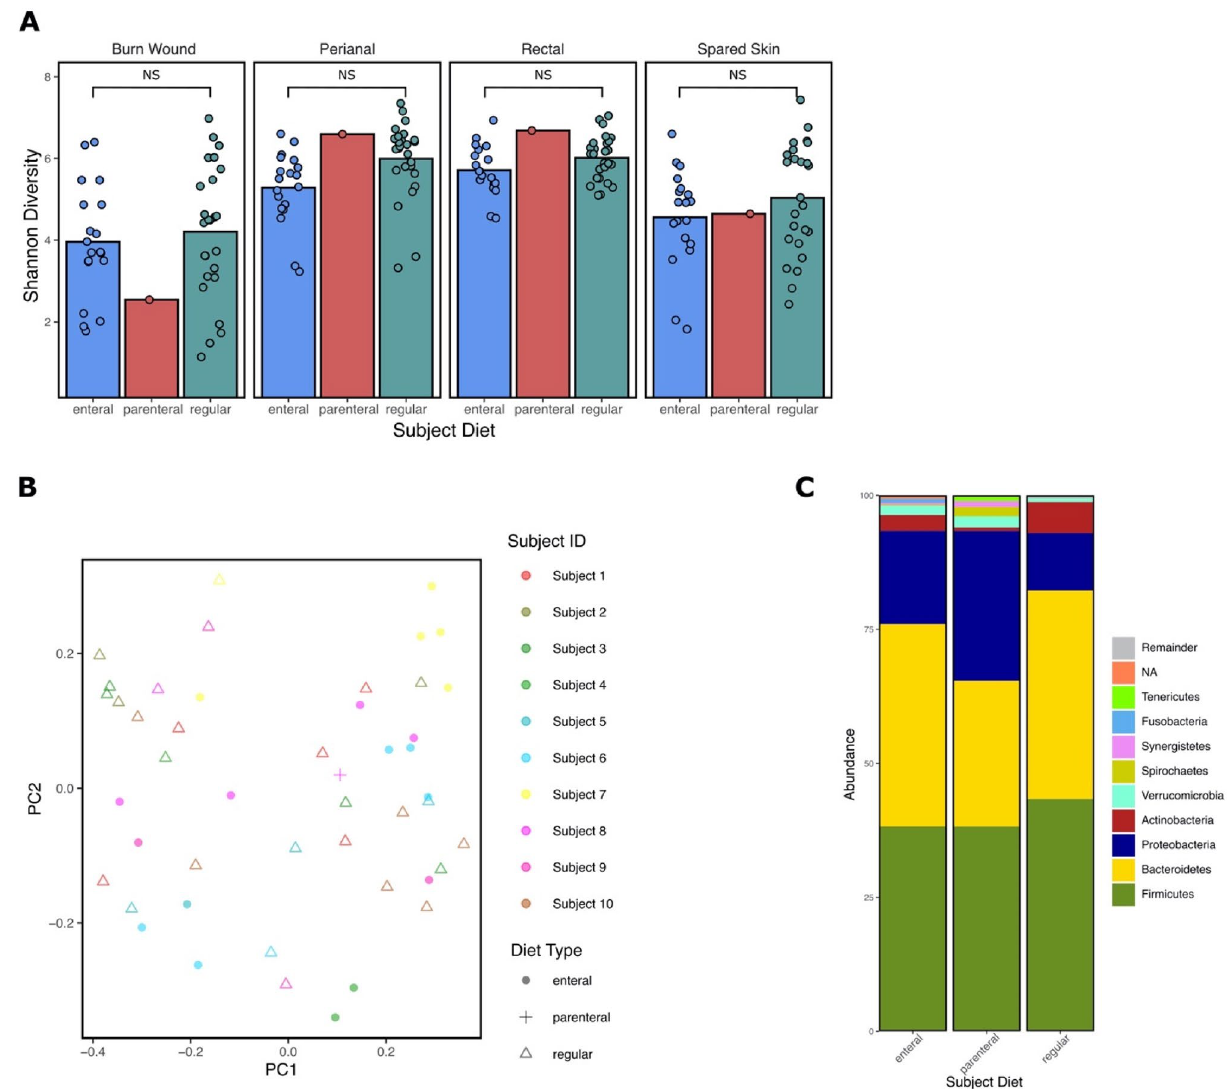
Figure 7. Nutritional impacts on burn patient microbial diversity and taxonomy. ( A ) Mean Shannon Diversity between diet type that each patient received during the collection timepoint for each collection location (burn wound, spared skin, perianal, and rectal) sampled. ( B ) PCOA plot of Bray Curtis dissimilarly of rectal samples illustrates compositional diversity complicated by significant within group variation ( P = 0.036) and inter-subject variation ( P = 0.001). The first and second principal components (PC1 and PC2) are shown, explaining 17.08% and 7.367% of the variance, respectively. ( C ) Taxonomic summary of the top 10 phyla sequenced from the sum of perianal and rectal samples separated by diet type at the time of collection. “NA” represents unclassified phyla. This figure was generated using the software Inkscape and visualizations generated by healthy volunteers, and that BICU nurses may also experience alterations in microbial community composition from cutaneous populations sampled from the forearm. Treatments such as antibiotics, grafting, and nutritional formulations can impact the diversity and community compositions sampled during the patient’s ICU stay. Surprisingly, the topical antimicrobial applied at the wound did not result in a significant difference of relative abundance in any AVSs. In addition, it is possible to detect changes in relative abundance of clinically identified infectious bacteria at the burn wound, even if it is not the site of the culture location. Due to the impact that sepsis can have on patient outcome, further research in establishing burn wound bacterial profiles can aid in the development of tools to detect pathogenic changes.